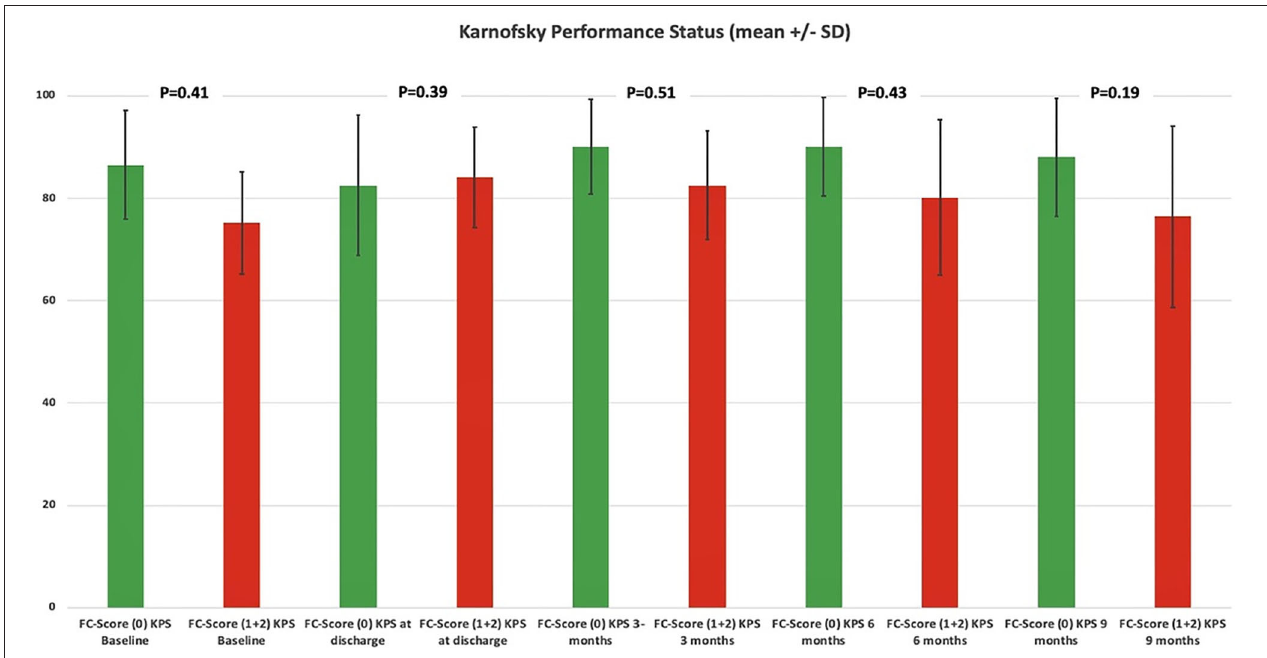
FIGURE 5 | Functionality according to the Karnofsky Performance Status among dichotomized FC scores. Means (column) and 95% confidence intervals (lines) for the Karnofsky Performance Status, illustrating the degree of functionality in the period from admission to follow-up examination at 9 months stratified by the parameters FC score 0 (green column) and FC score ≥ 1 (red column). p -values of the Student’s t -test are